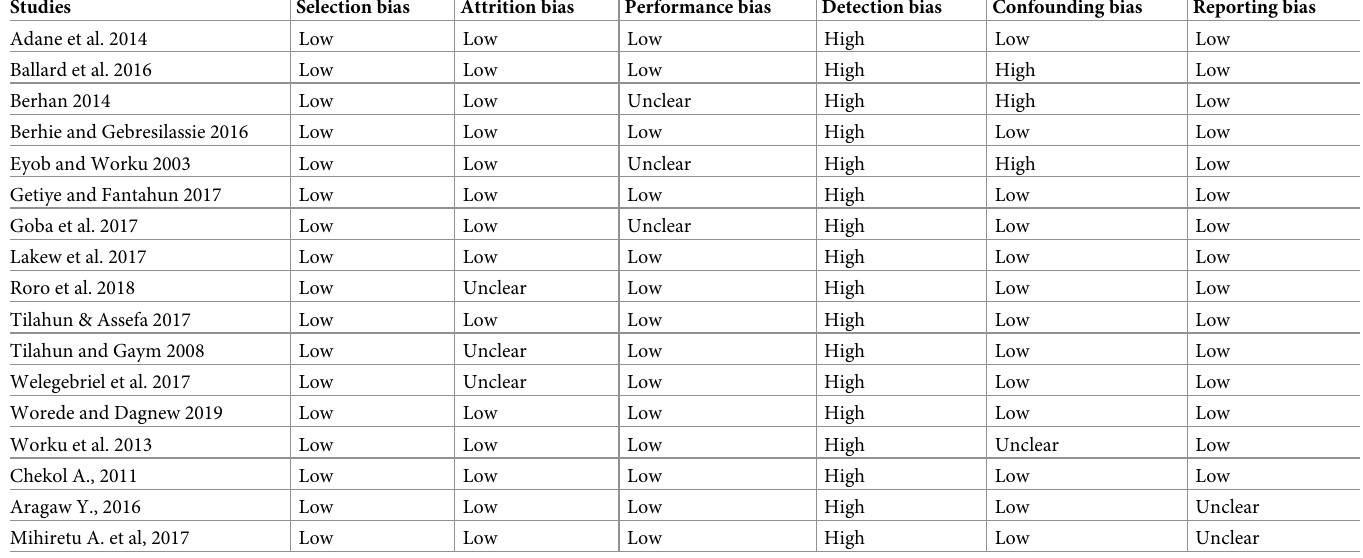
Table 2. Individual studies risk of bias on effect of ANC on perinatal outcomes in